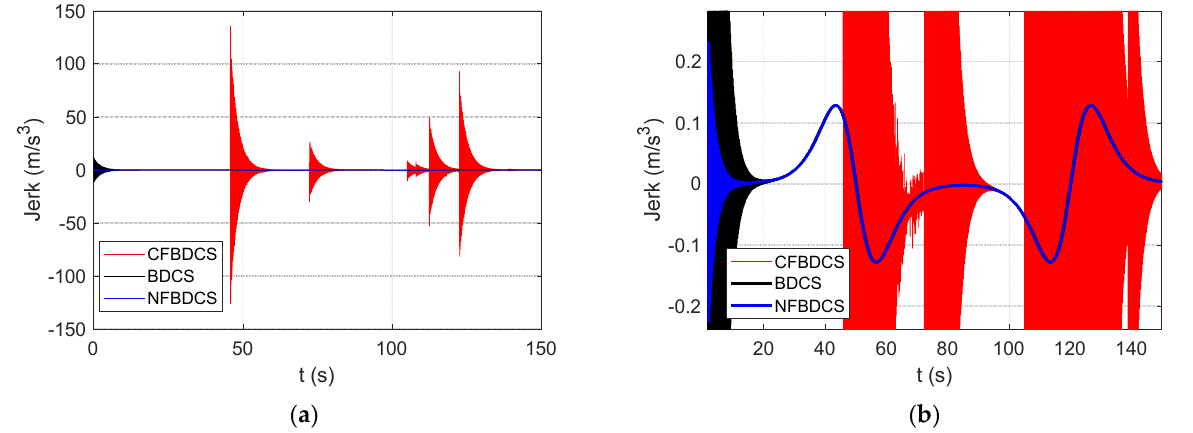
Figure 22. Vehicle driving mode with Δ t = 0.1 s.